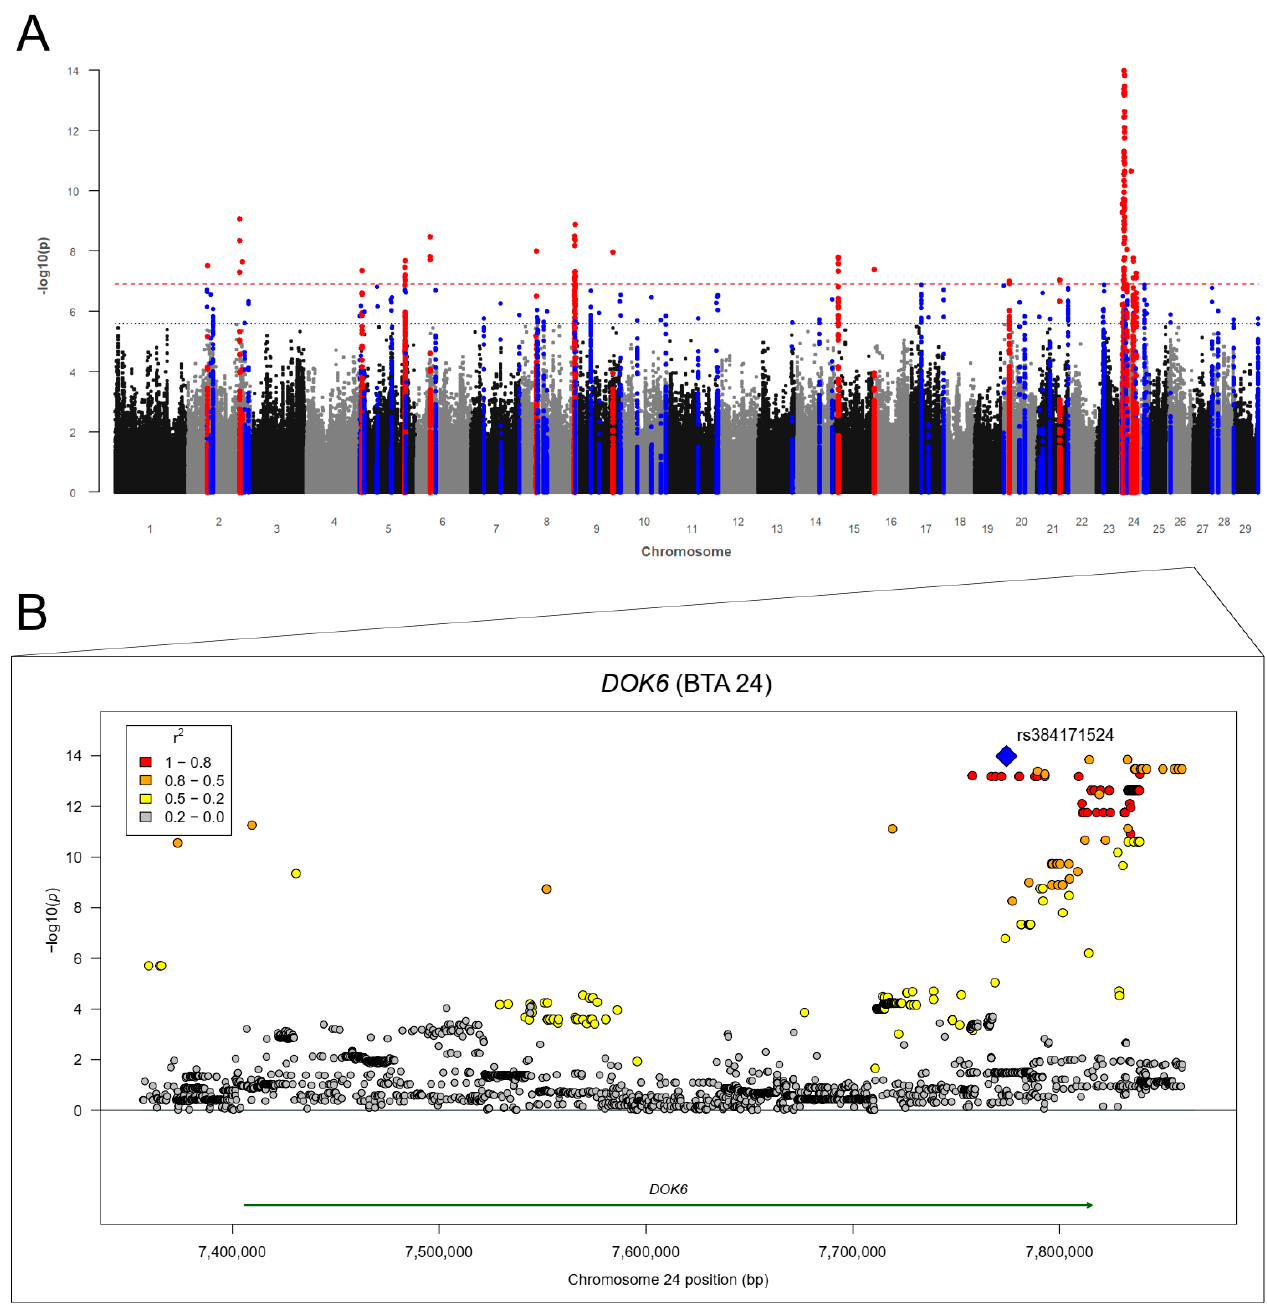
Figure 5. ( A ) Manhattan plot for − log10 p -values of marker effects for residuals for fecal larvae counts of Dictyocaulus viviparus (RES-DV); markers above the genome-wide significance threshold p Bonf (red dashed line) are highlighted in red and markers above the suggestive significance threshold p Sug (blue dashed line) are highlighted in blue. Markers within a distance of 125 kb up- and downstream of the significantly or suggestively associated SVs are highlighted in red or blue, respectively. ( B ) Regional association plot for the docking protein 6 ( DOK6 ) gene on BTA 24 with corresponding flanking regions (+/ − 100,000 bp). The SNP rs384171524 (blue square) was the highest associated SNP ( p = 1.04 × 10 − 14 ) for RES-DV. Circles show GWAS p -values, with different colors indicating linkage disequilibrium (LD): red: LD 0.8 to 1.0, orange: LD 0.5 to 0.8. yellow: LD 0.2 to 0.5, gray: LD 0.0 to 0.2.